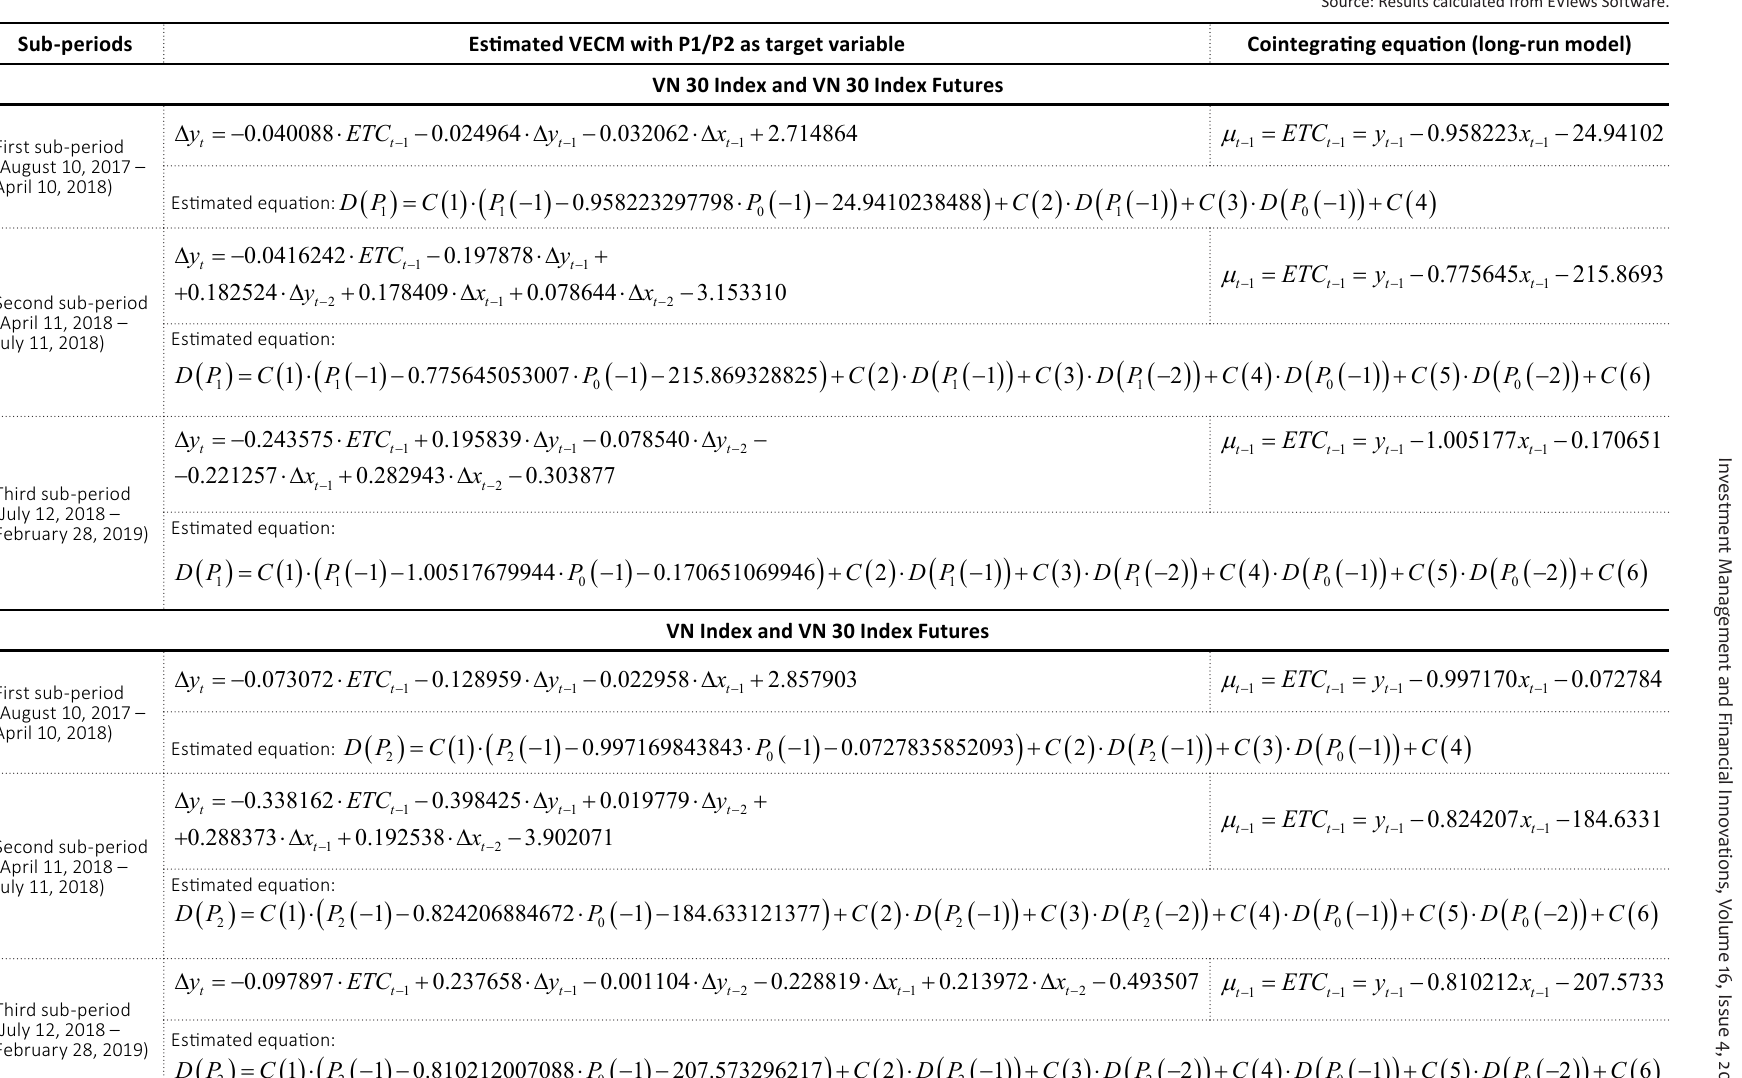
Table 5. Estimated VECM and cointegrating equation (long-run model)